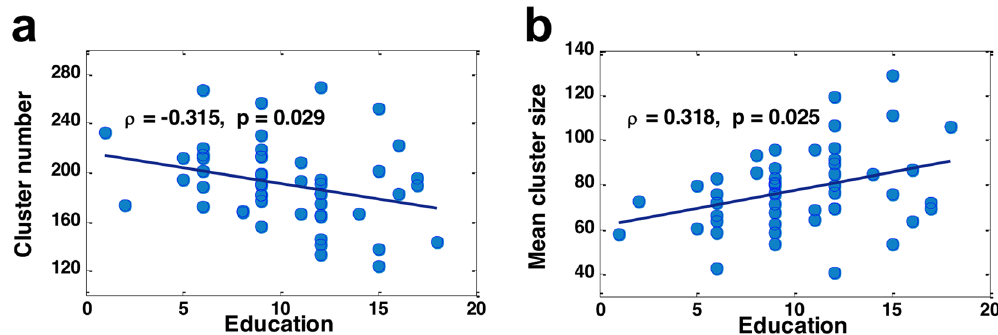
Figure 7. ( a ) The relationship between HRC number and years of education. ( b ) The relationship between mean HRC size and years of education. In this figure, HRCs here were defined as the 10% highest ReHo voxels for each individual and were constrained by grey matter